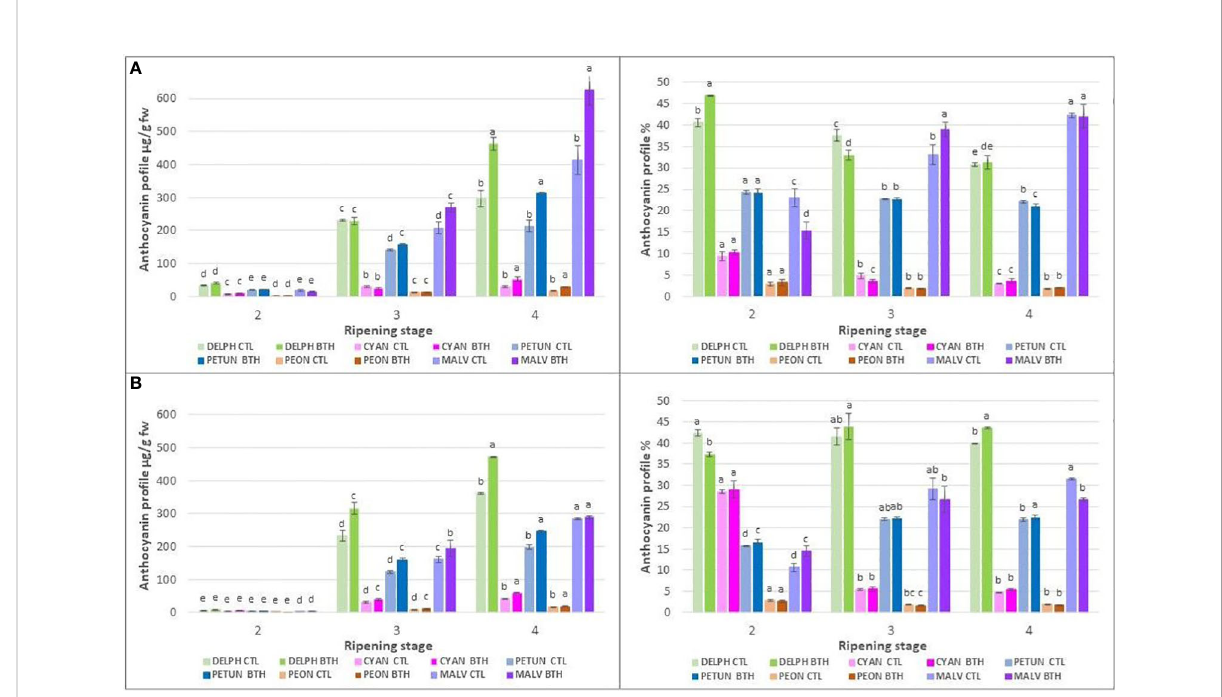
FIGURE 4 Effect of BTH treatment on total amounts (left) and relative proportion (right) of individual anthocyanins (clustered into the representative anthocyanidin classes) in cv (A) ‘ Duke ’ and (B) ‘ Brigitta ’ . Values represent means ± SE (n = 6). Different letters indicate statistical differences (p ≤ 0.05) among ripening classes and between treatments, for each